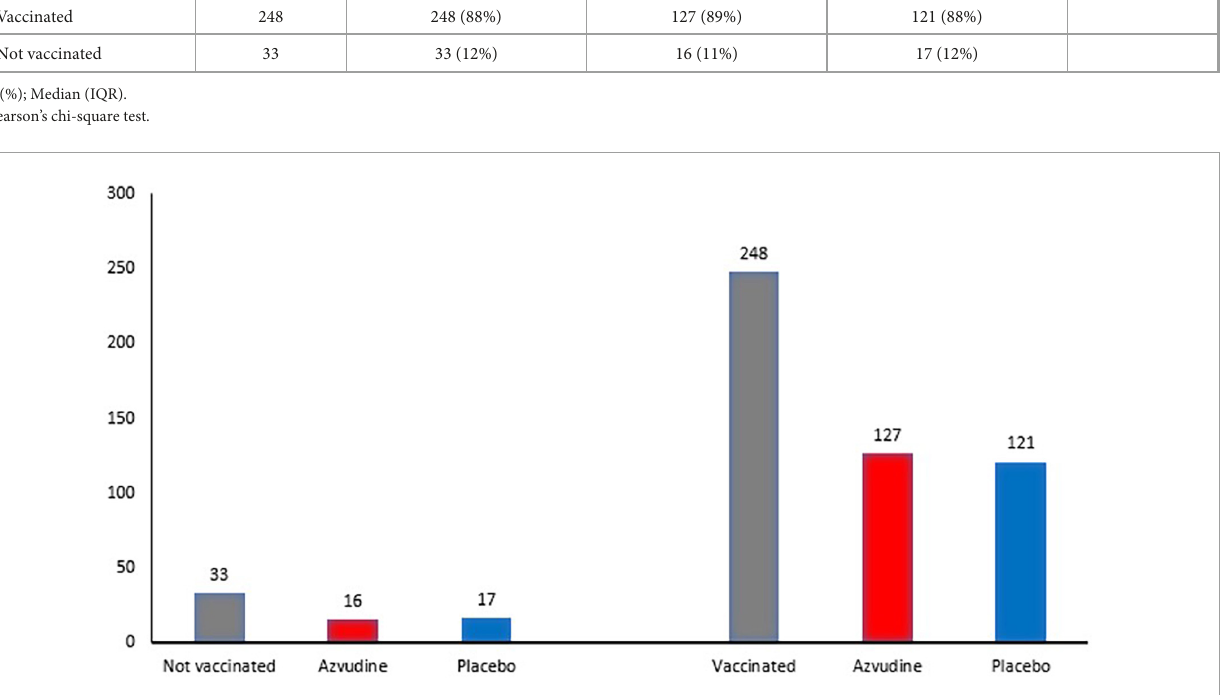
The results indicate that participants treated with FNC had a significantly shorter time to first nucleic acid negative conversion (5.55 days; p < 0.001) compared to participants treated